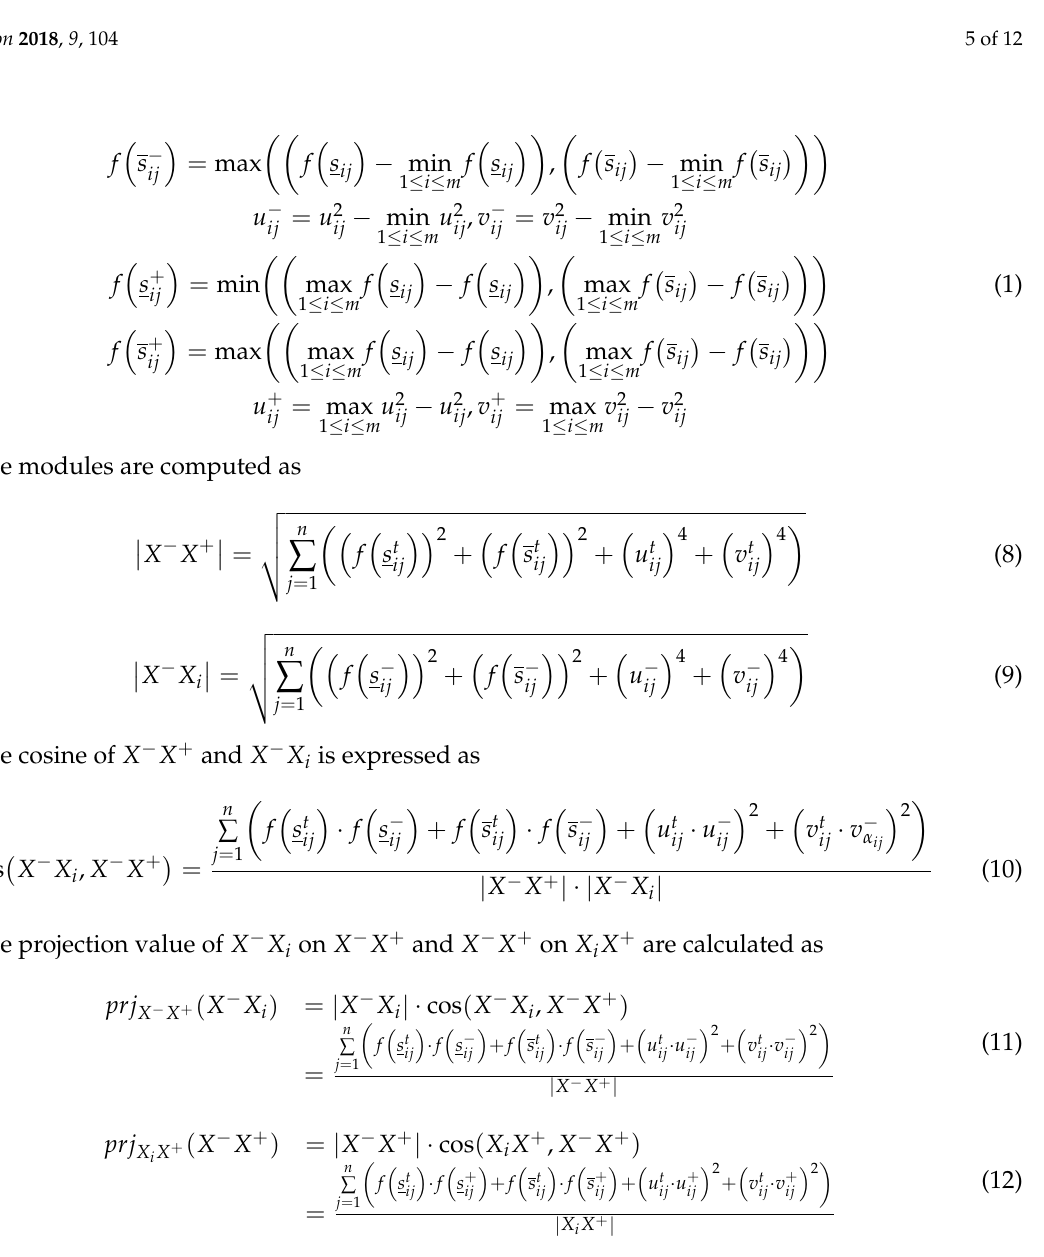
prj and . Figure 1. The graphical representation of prj X − X +